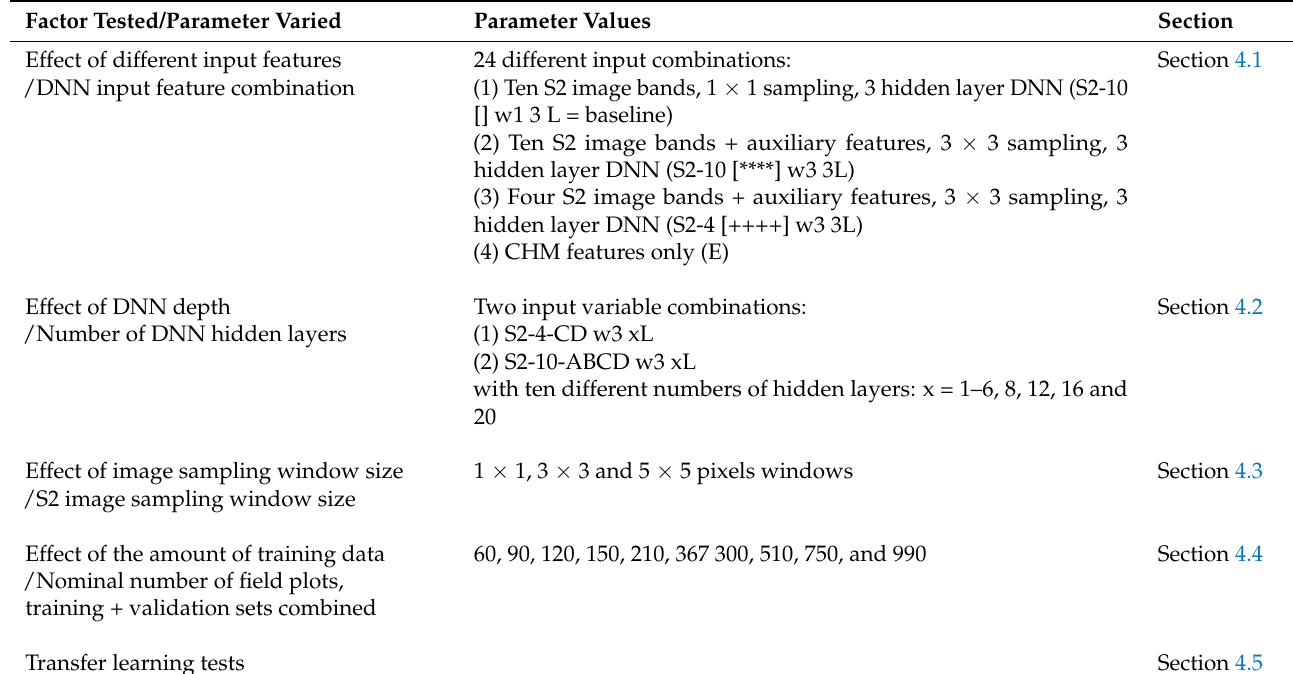
Table 7. Details of different test setups to study the influence of various factors on the performance of the deep neural network model. Input data sources are described in Table 3. Refer to the corresponding subsection for results of the different test setups. Coding of test setups: S2-4 = Sentinel-2 bands B2, B3, B4, and B8 (at 10 m resolution)); S2-10 = Sentinel-2 bands B2, B3, B4, B5, B6, B7, B8, B8A, B11, and B12 (20 m bands resampled to 10 m); **** = none, 2, 3 (= B), 4, 5, 6, 7, 8 (= E), 9, A,